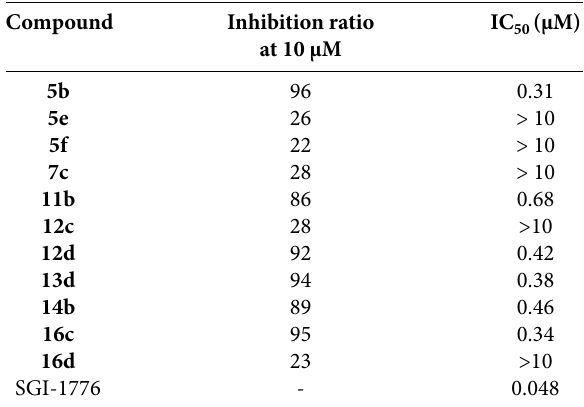
Table 3. Inhibition of Pim-1 kinase by compounds 5b , 5e , 5f , 7c , 11b , 12c , 12d , 13d , 14b , 16c and 16d 5b